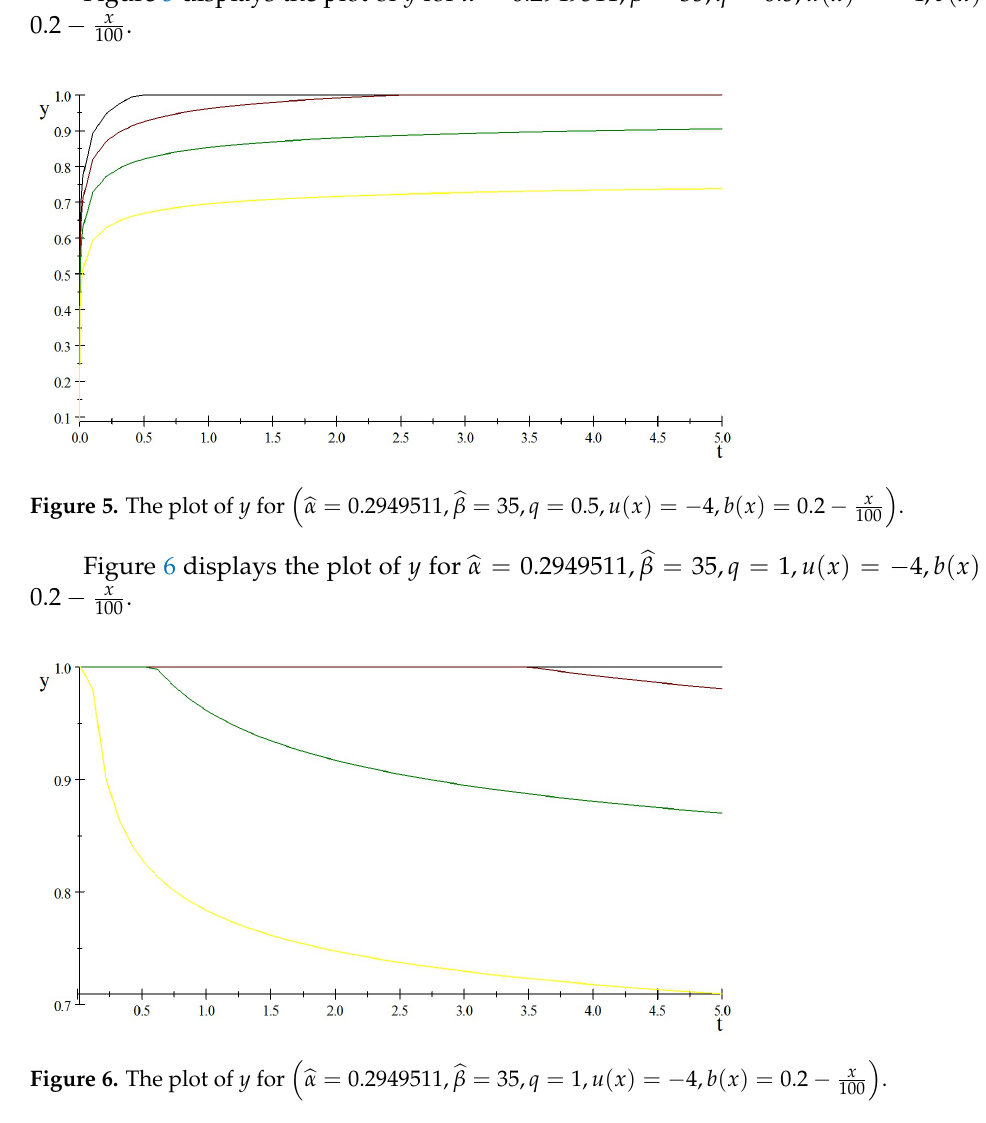
(cid:16) (cid:98) α = 0.2949511, (cid:98) β = 35, q = 1, u ( x ) = − 4, b ( x ) = 0.2 −